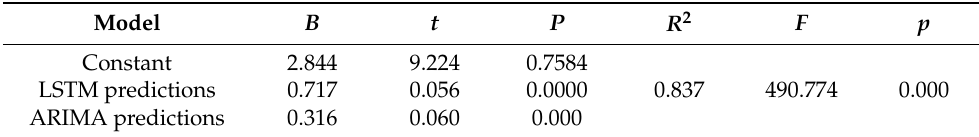
Table 2. Regression coefficients.